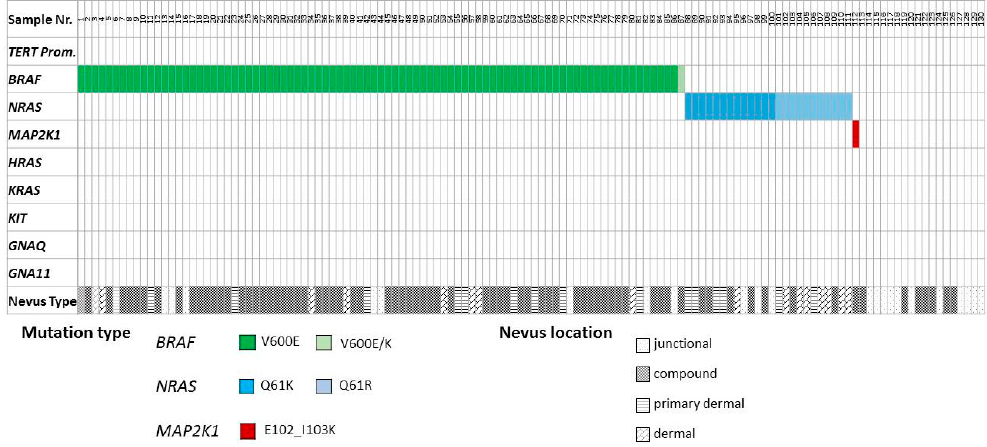
Figure 1. Distribution of activating mutations identified in acral naevi. Distribution of activating mutations identified in different oncogenes in the acral naevus cohort. The resulting amino acid changes as well as naevus location (junctional, compound, primarily dermal, or dermal) are color-coded according to the scheme underneath the illustration.